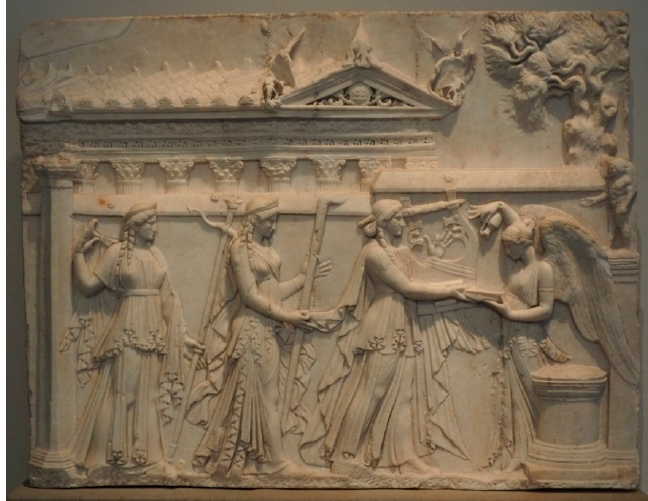
Figure 10. Archaistic relief (late first century BC) of the so-called ‘Kitharoidos’ type, with the Apolline Triad on an architectural background, Berlin, Antikensammlung Sk 921; © photograph by author.